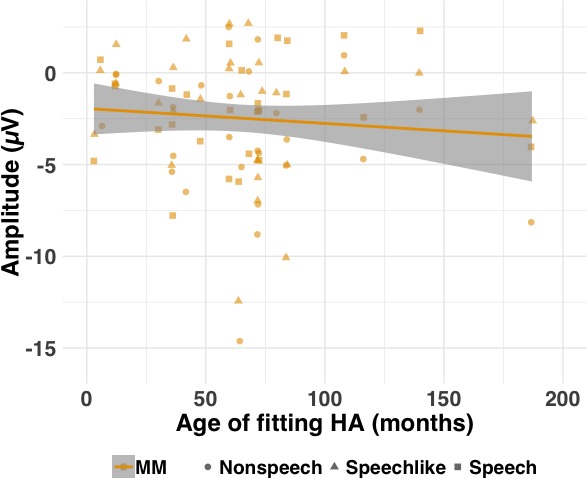
Amplitude (μV) of the MMN as a function of age of fitting with hearing aids (in months).Individual (shapes) data are shown for each condition (nonspeech = circles; speech-like = triangles, speech = squares) for the MM group. Shaded lines represent the 95% confidence interval. Note that the age at which children with MMHL were first fit with their hearing aids was correlated with BEPTA thresholds (r = −0.546, df = 28, p=0.002); That is, children with lower (better) BEPTA thresholds tended to receive their hearing aids later. Therefore, a partial correlation between MMN amplitude and age of first hearing aid fitting was computed, with BEPTA threshold as a covariate. This partial correlation failed to reach significance (pr = 0.246, df = 28, p=0.190).